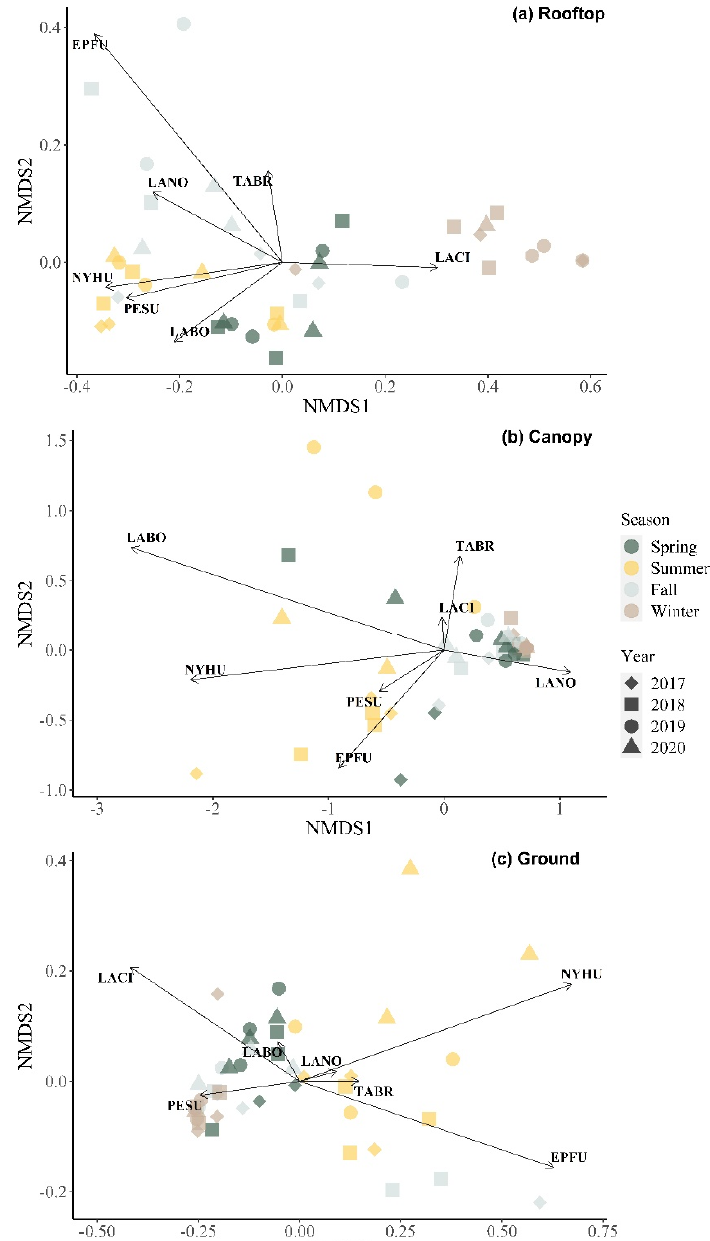
Figure 6. NMSD plots showing monthly bat community composition varied among seasons and across years at three sites at the Greensboro Science Center in Greensboro, North Carolina, USA. Each panel for a site: ( a ) rooftop level (stress 0.042); ( b ) canopy level (stress 0.144); ( c ) ground level (stress